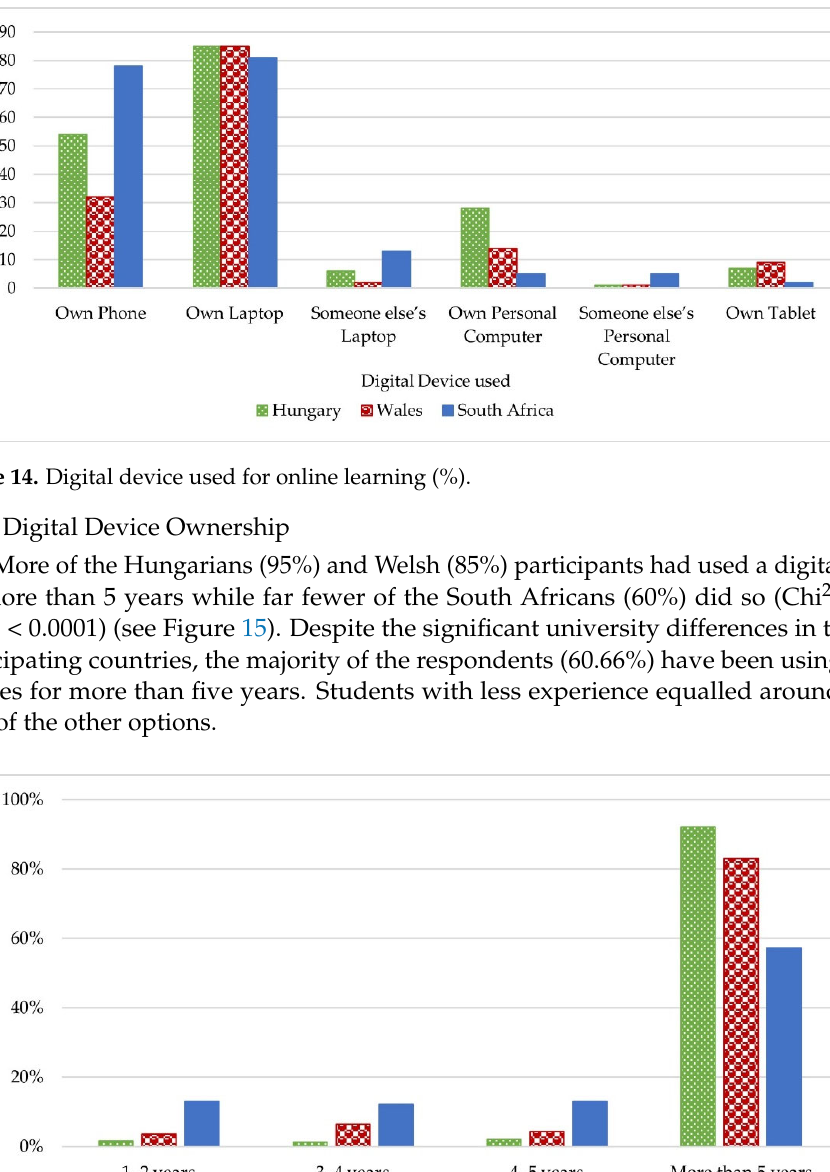
Table 1. The impact of the pandemic on learning